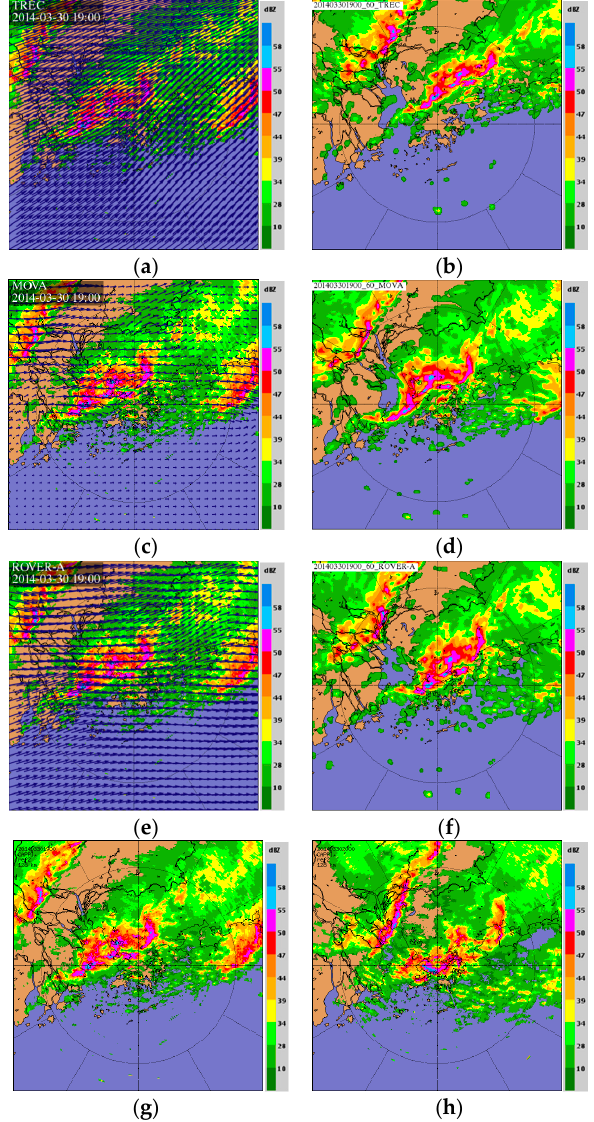
Figure 7. Reflectivity and motion field based at 19:00 (HKT/UTC + 8) on 30 March 2014 (base time). ( a ) Reflectivity and motion field of TREC at base time; ( b ) Forecast reflectivity of TREC at 1 h from the base time; ( c ) Reflectivity and motion field of MOVA at base time; ( d ) Forecast reflectivity of MOVA at 1 h from the base time; ( e ) Reflectivity and motion field of ROVER at base time; ( f ) Forecast reflectivity of ROVER at 1 h from the base time; ( g ) Actual radar reflectivity at base time; and ( h ) Actual radar reflectivity at 1 h from the base time.